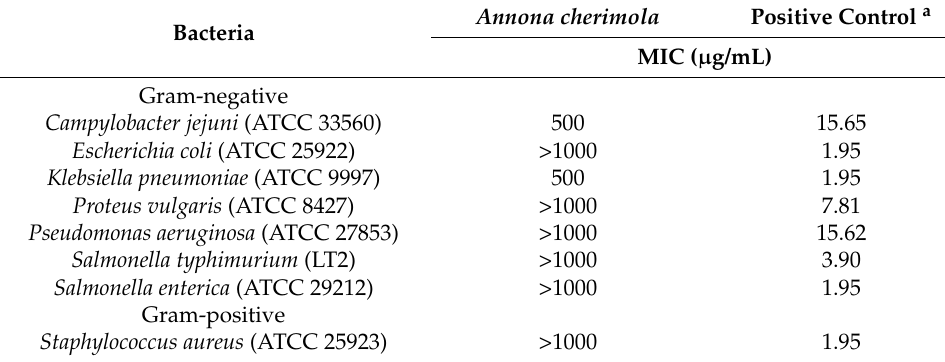
Table 4. Antibacterial activity of essential oil from Annona cherimola leaves.